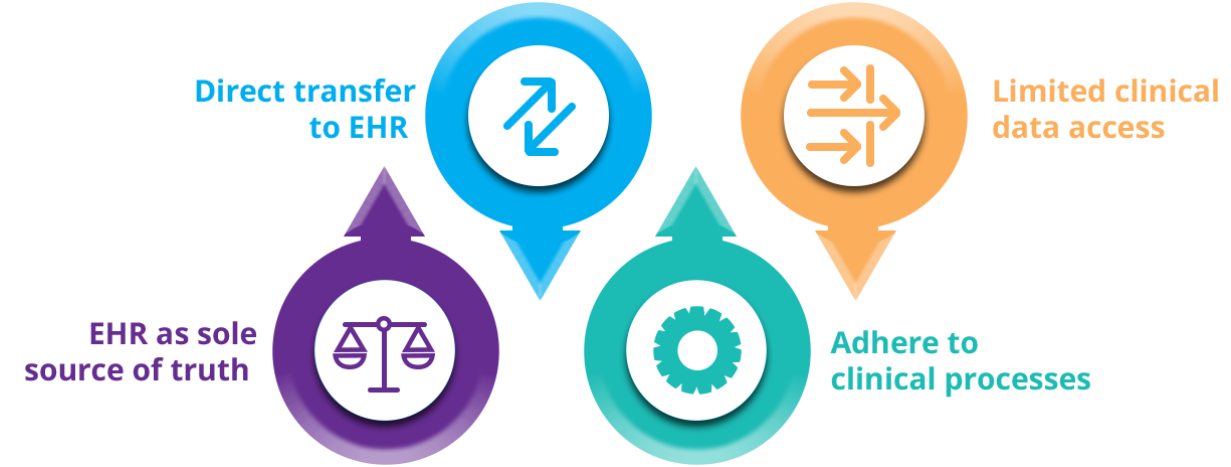
Figure 3. Four key principles of REDCap (Research Electronic Data Capture) integration with the Centre for Addiction and Mental Health EHR. EHR: electronic health